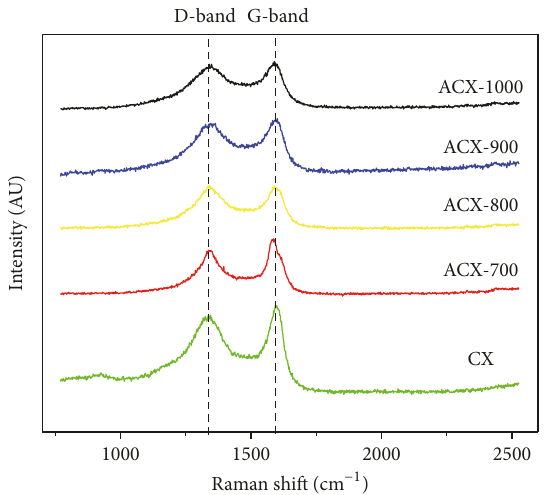
Figure 3: Raman spectra of CX, ACX-700, ACX-800, ACX-900, and ACX-1000.